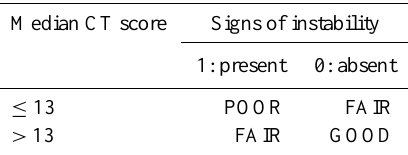
Table 2. Slope stability classification based on the slope median point stability and signs of instability (recent avalanching, whumpfs of shooting cracks). Median CT score Signs of instability